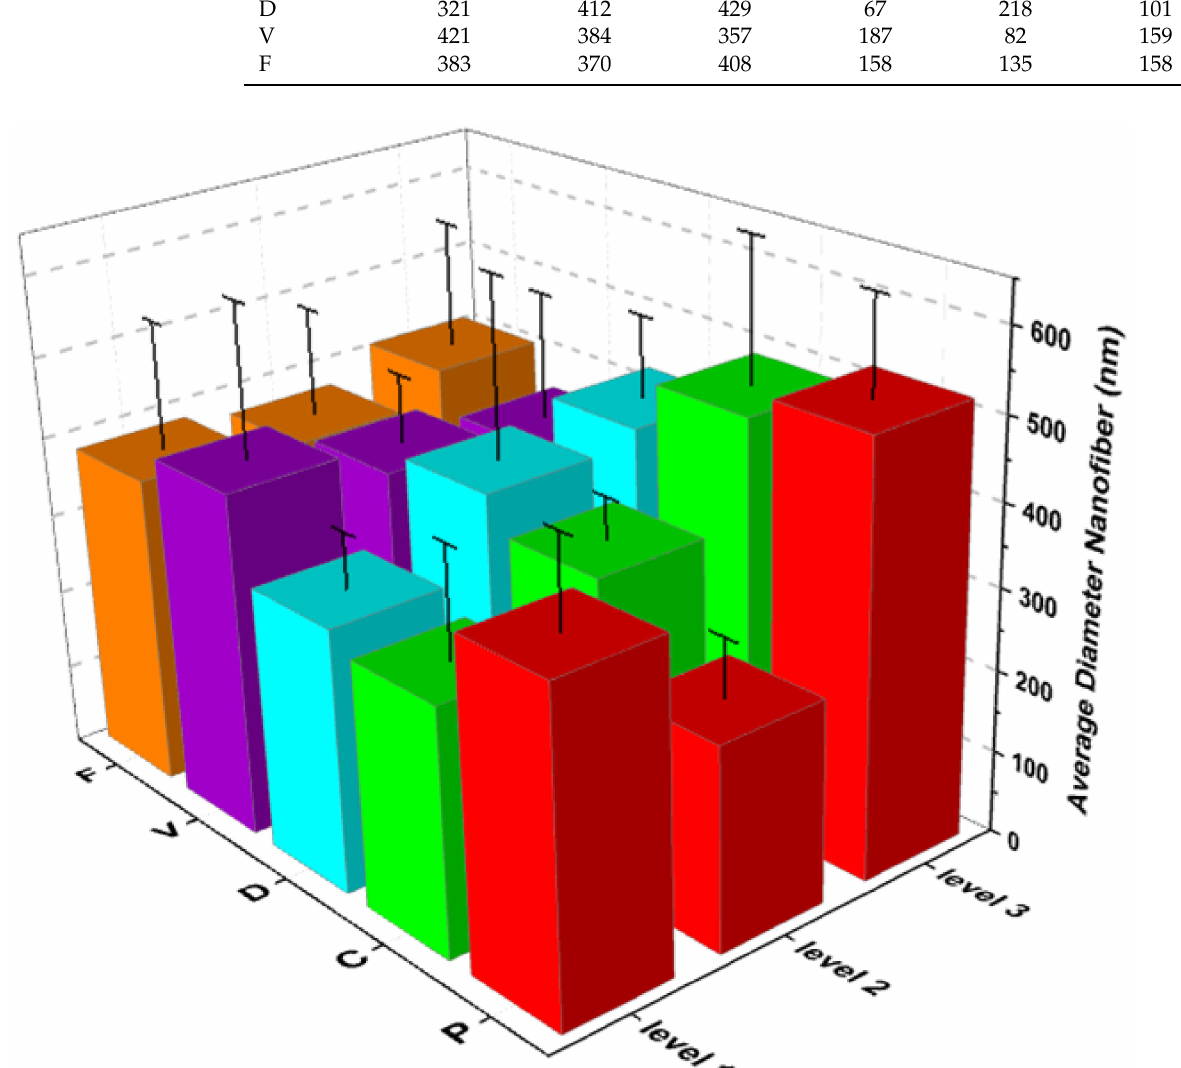
Figure 5. The effect of distance between the needle and collection plate (D), the concentration of polymer solution (C), the applied voltage (V), the solution feeding rate (F) and type of polymers (P) on the average electrospun nanofiber